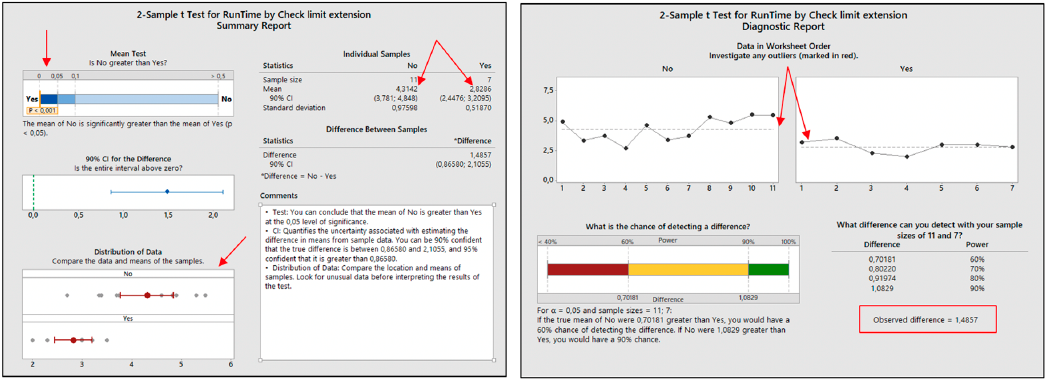
Figure 8. Run time decrease after Muda removal.